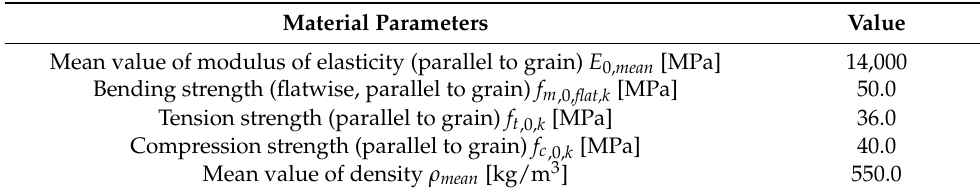
Table 2. The material parameters of LVL [35]. Material Parameters Value Mean value of modulus of elasticity (parallel to grain) E 0, mean [MPa]